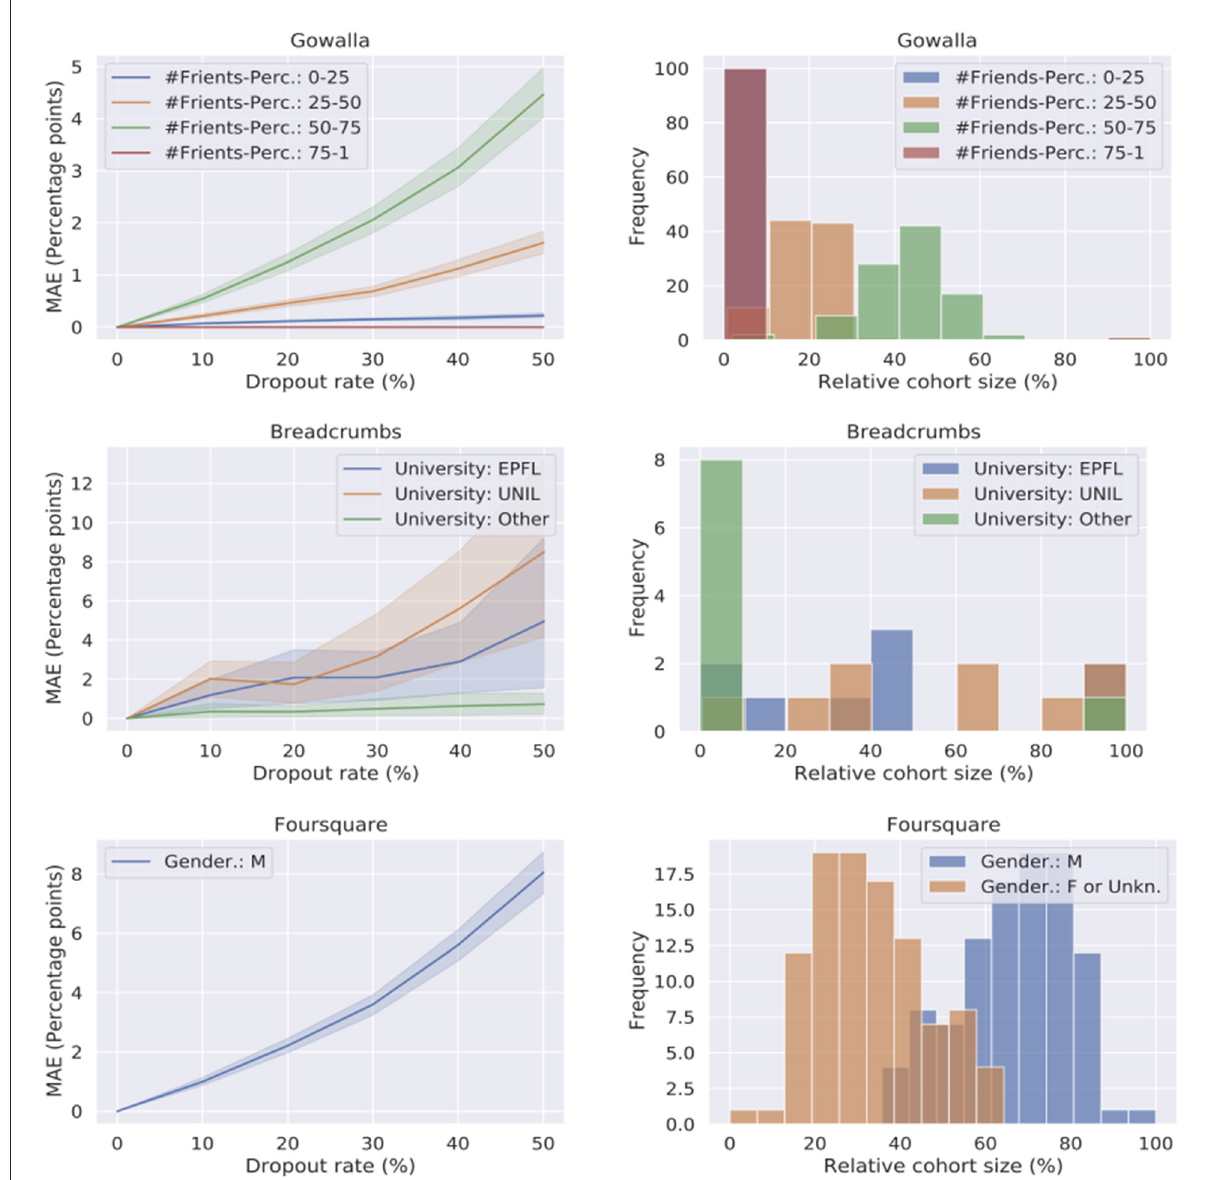
FIGURE7 The three figures in the left column represent the relation between dropout rate (x-axis) and the corresponding Mean Absolute Error (y-axis) averaged across all POIs in each dataset. The shaded areas represent 95% confidence intervals. The three figures in the right column represent the distribution of the relative cohort size calculated over all POIs in one dataset. Each row represents one dataset (from top to bottom: Gowalla, Breadcrumbs and